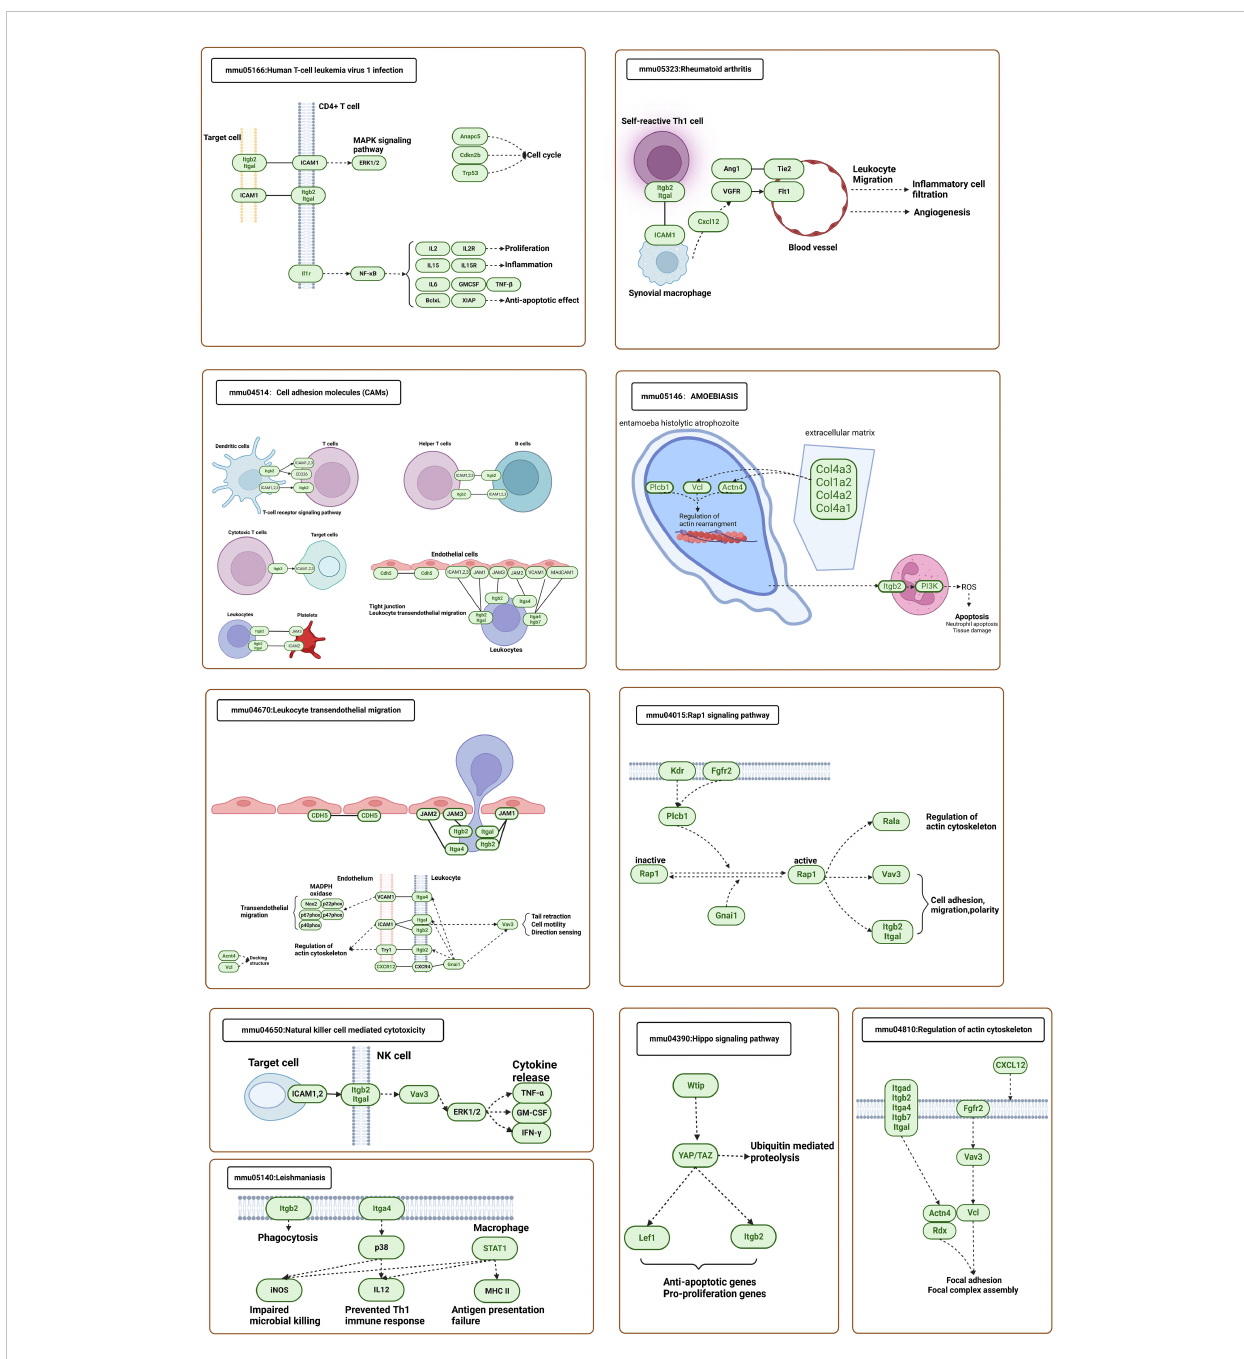
FIGURE 8 KEGG analysis of the representative MCODEs together with Itgb2 in